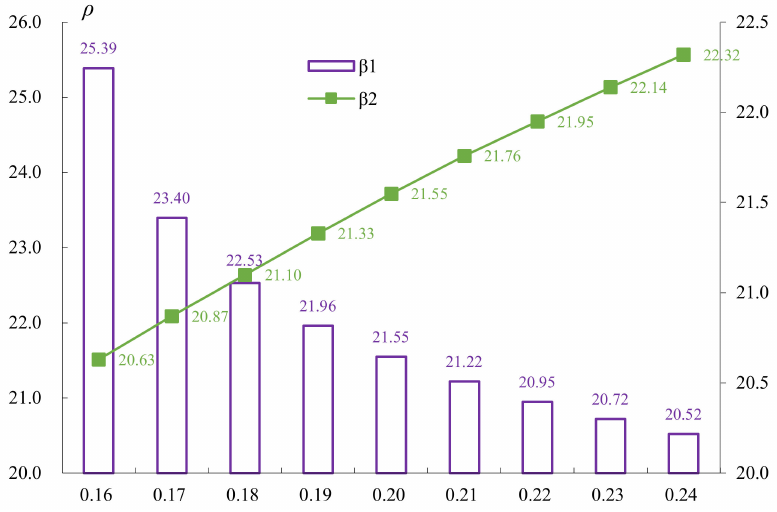
Figure 7. E ff ect of β 1 and β 2 on ρ